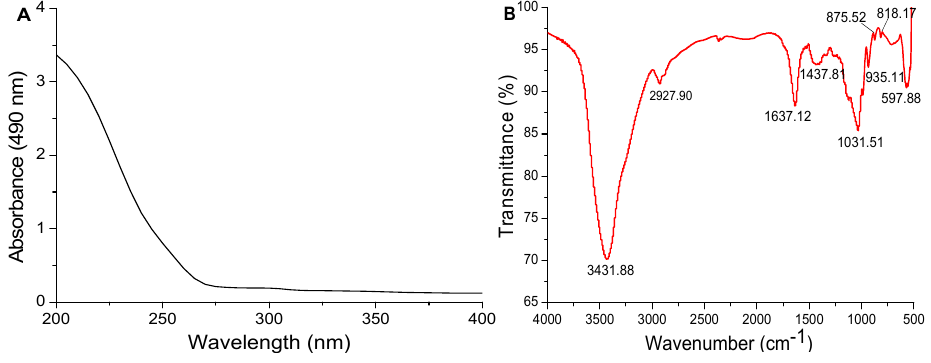
Figure 2. ( A ) UV and ( B ) FT-IR spectra of PD1-1.